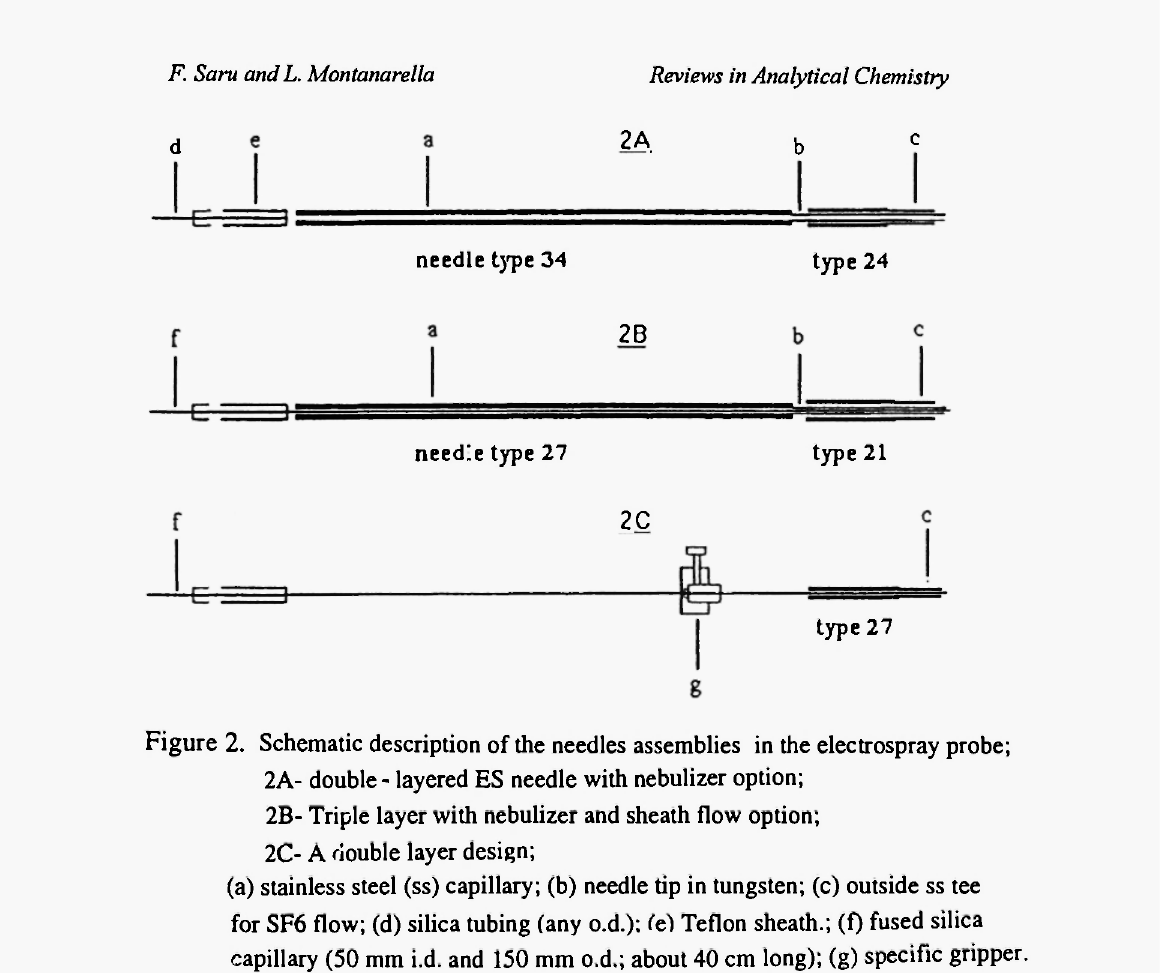
Figure 2. Schematic description of the needles assemblies in the electrospray